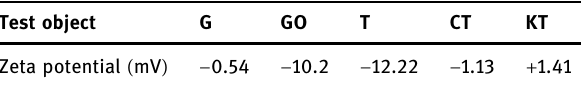
Table 5: Zeta potential test results